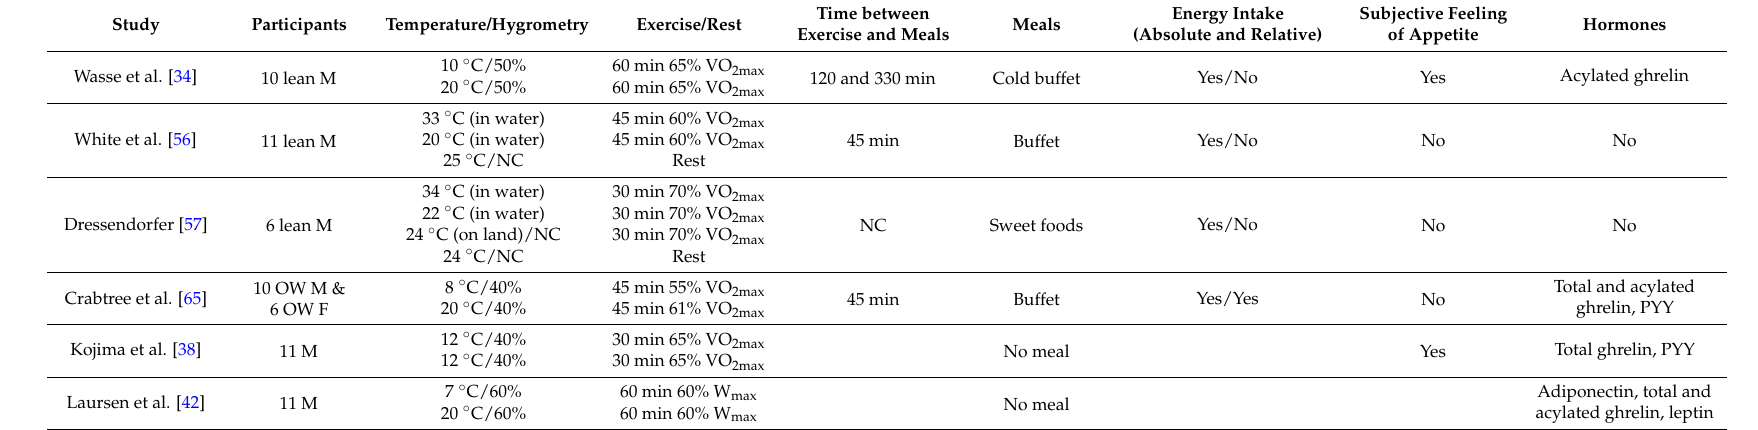
Table 2. Description of studies conducted under cool